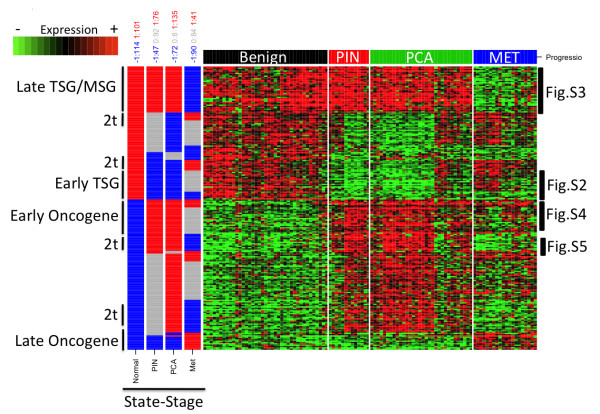
State-Stage representation of significantly selected genes using BSM. State-Stages are represented as active=1 in red, inactive=−1 in blue, or uncertain=0 in gray. Stages are indicated. Samples are shown in columns whereas genes are ordered by stage-state profile in vertical. Expression values ranges from 0 to 1 corresponding to various levels of colors from green to black then to red. Rank given by SAM is shown for comparison (black represents ranks from 1 to 215, dark gray to 500, light gray to 1000, and white >1000).